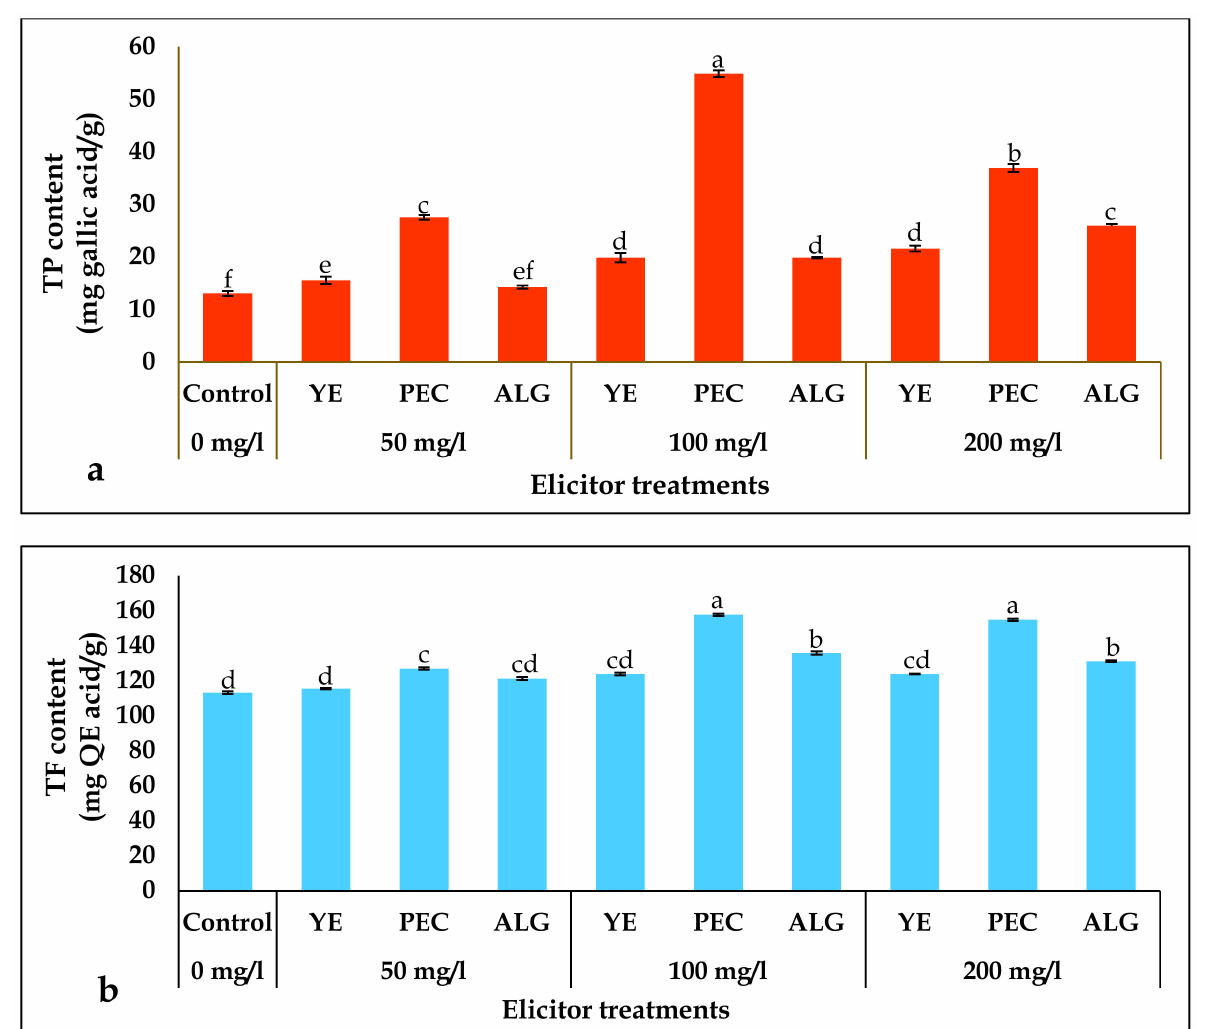
Figure 2. Effect of elicitor treatments on TP and TF contents in P. tuberosa shoots: ( a ) TP content (mg gallic acid/g), ( b ) TF content (mg QE acid/g). Note: Values are mean ± SD, means in a column followed by different letters are significantly different from each other at p < 0.05. Mean values followed by the same letter(s) in a column are not significantly different ( p < 0.05) based on